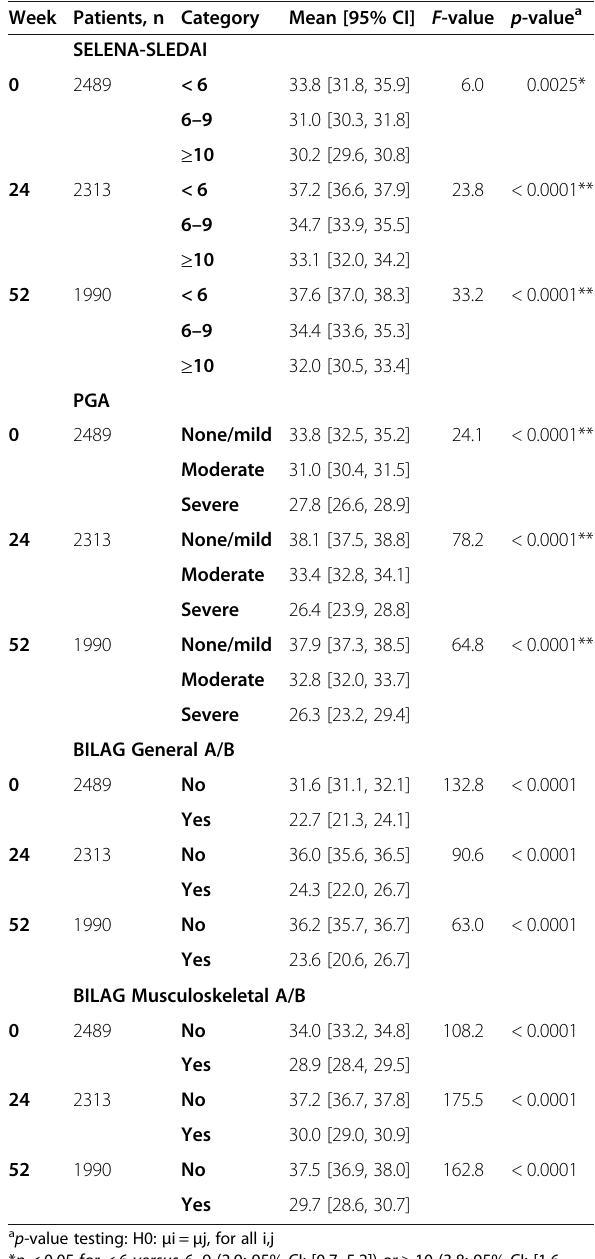
Table 4 Mean FACIT-Fatigue scores across various criterion measures (pooled population) Week Patients, n Category